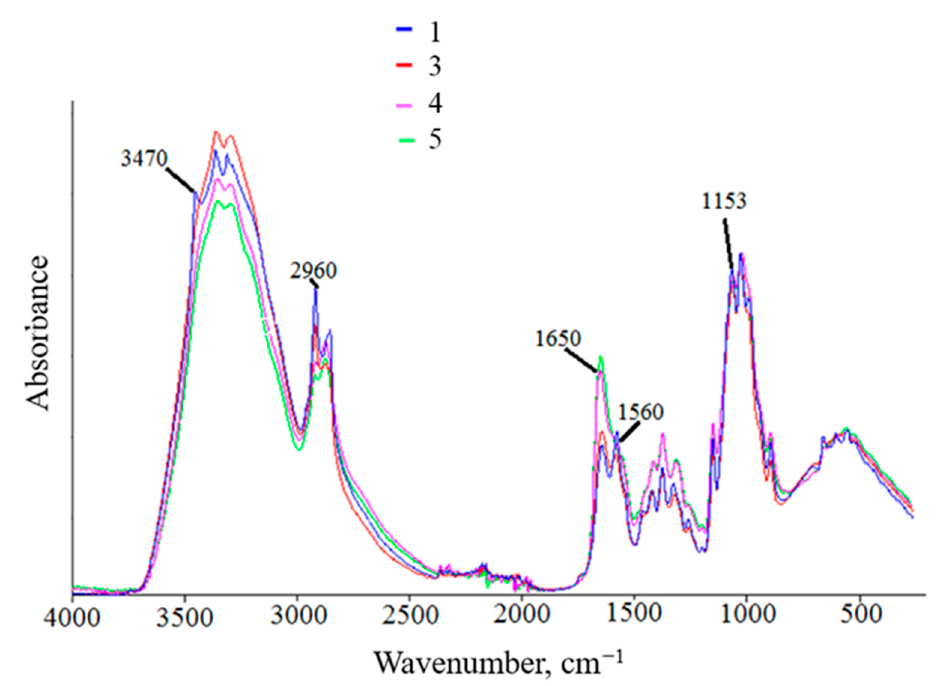
Figure 3. IR spectra of the samples with various contents of NMA: 0 wt% (1, initial chitosan sample); 10 wt% (3); 20 wt% (4); 30 wt% (5), the sample number corresponds to those of experiments in Table 1.